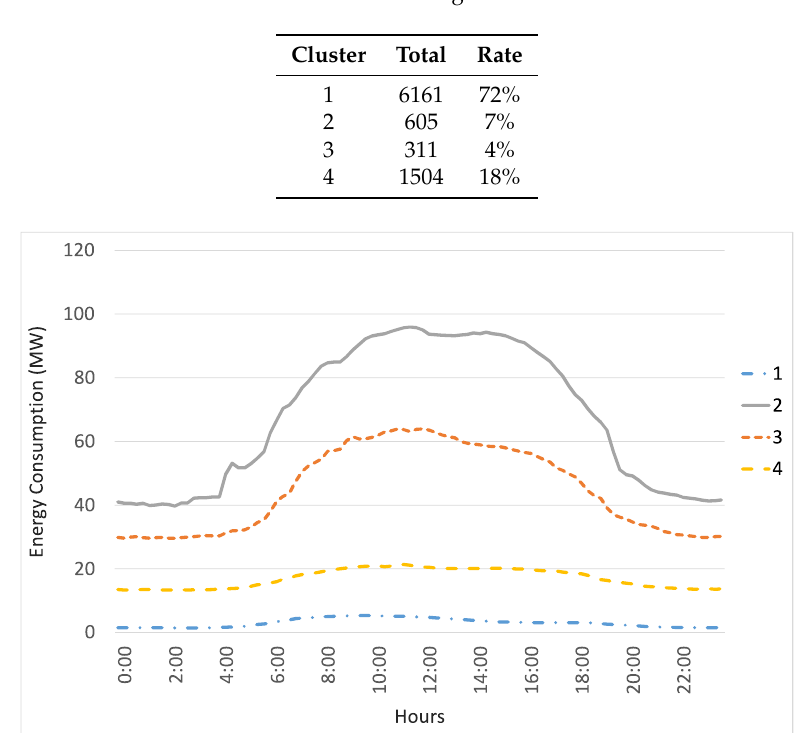
Table 4. Instances along the clusters.